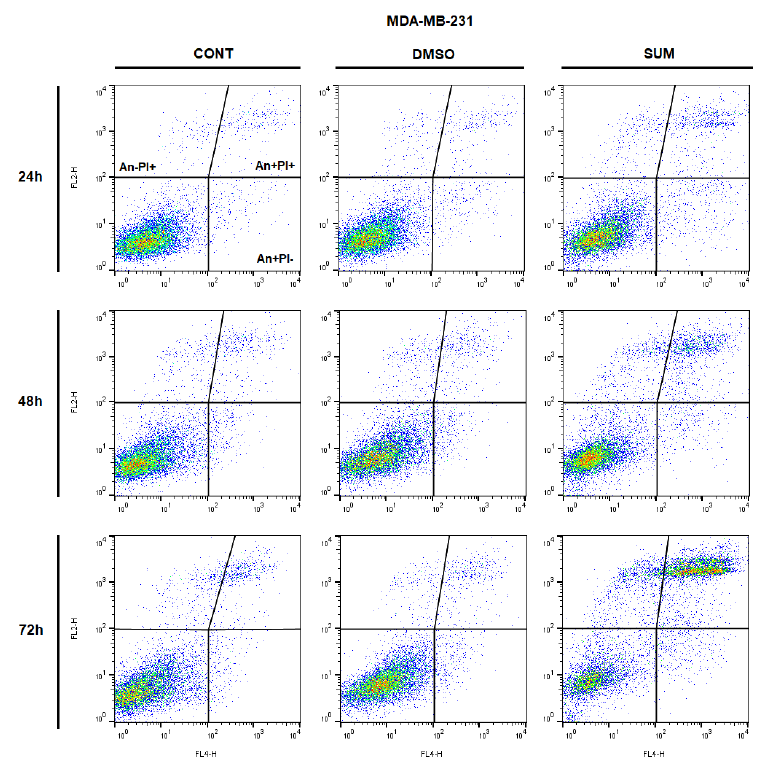
Figure 13. Representative diagrams of apoptotic cell diversification in MDA-MB-231 cells after SUM treatment (215 µg/mL).